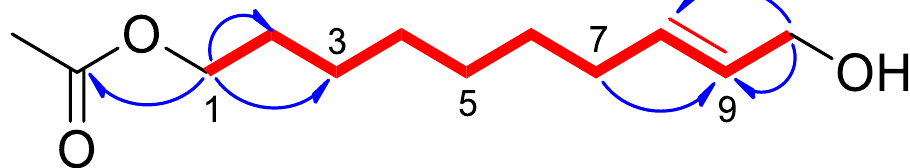
Figure 2. Selected correlations observed in the COSY ( ▬ ) and HMBC ( → ) NMR spectra of com- pound 1.